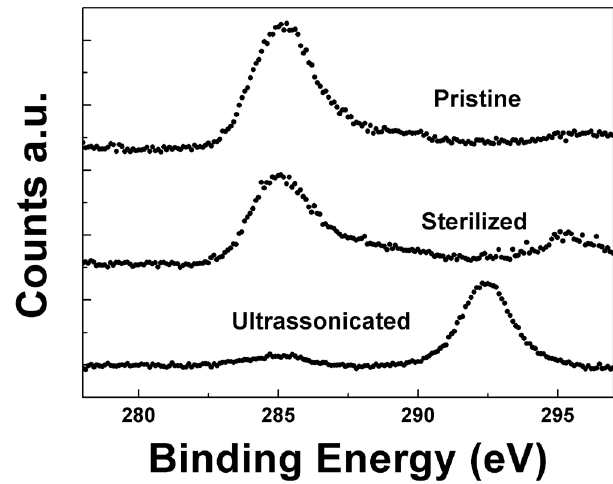
Fig. 5 – XPS spectra of samples from guide wire catheter type C: pristine – C1, sterilized in ethylene oxide – CS1 and ultrasonically cleaned with enzymatic detergent – CU1.